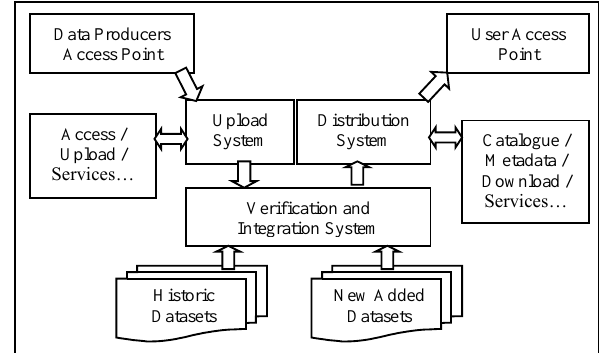
Figure 4. A technical creation/maintenance/sharing mechanism From figure 4, there are three core systems: the upload